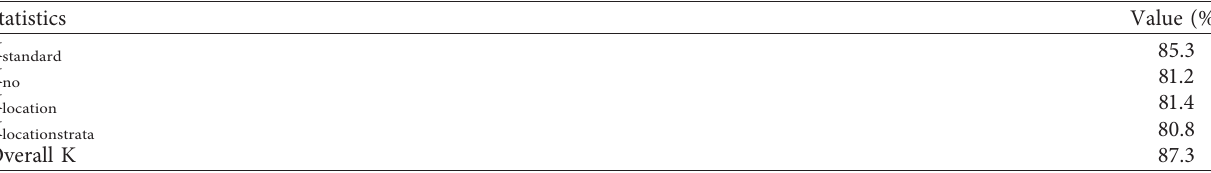
Table 9: Statistical validation of the CA-Markov chain model.